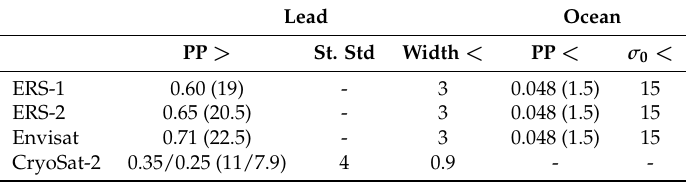
Table 2. Thresholds used in lead and ocean discrimination. The table columns are PP, stack standard deviation (St. Std), and width for lead discrimination and PP. Backscatter coefficient ( σ 0 ) for the ocean discrimination. The PP values are described as in [13] and in parenthesis as in [22]. The PP is calculated differently for CryoSat-2 (see the details in the text). The two numbers corresponds to SAR and SARIn, respectively. The width in ERS-1 is from the REAPER product and is the OCOG width, for ERS-2 and Envisat the width is the ALES+ leading edge rising time, and for CryoSat-2 the width is the width of the Gaussian fit. Lead Ocean PP > St. Std Width < PP < σ 0 < ERS-1 0.60 (19) - 3 0.048 (1.5) 15 ERS-2 0.65 (20.5) - 3 0.048 (1.5) 15 Envisat 0.71 (22.5) - 3 0.048 (1.5) 15 CryoSat-2 0.35/0.25 (11/7.9) 4 0.9 -